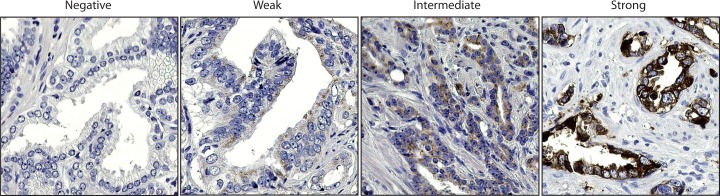
Immunohistochemical MUC1 staining in representative prostate cancer samples showing absent, weak, moderate and strong staining.